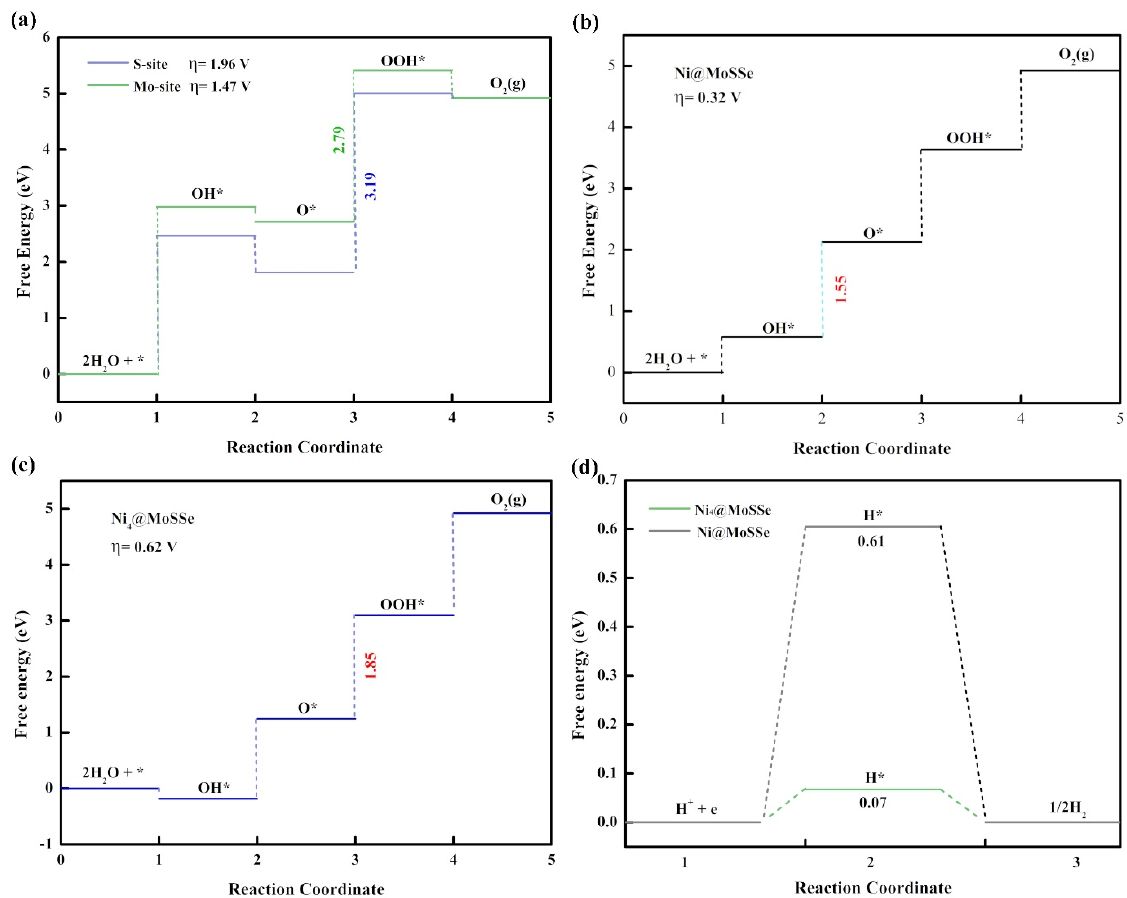
Figure 4. The free energy diagram for the OER of ( a ) pristine MoSSe, ( b ) Ni@MoSSe, ( c ) Ni 4 @MoSSe, ( d ) The free energy diagram for HER of the Ni 4 @MoSSe.